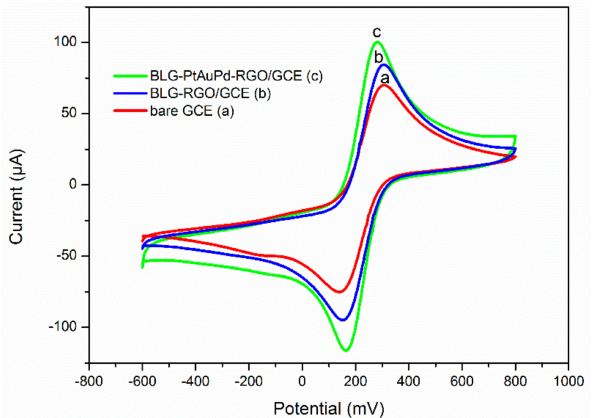
Figure 2. CVs of ( a ) bare glassy carbon (GC) electrode; ( b ) BLG-RGO/GC electrode; ( c ) BLG-PtAuPd- RGO/GC electrode recorded in 0.1 M KCl solution containing 10 mM [Fe(CN) 6 ] 3 − .